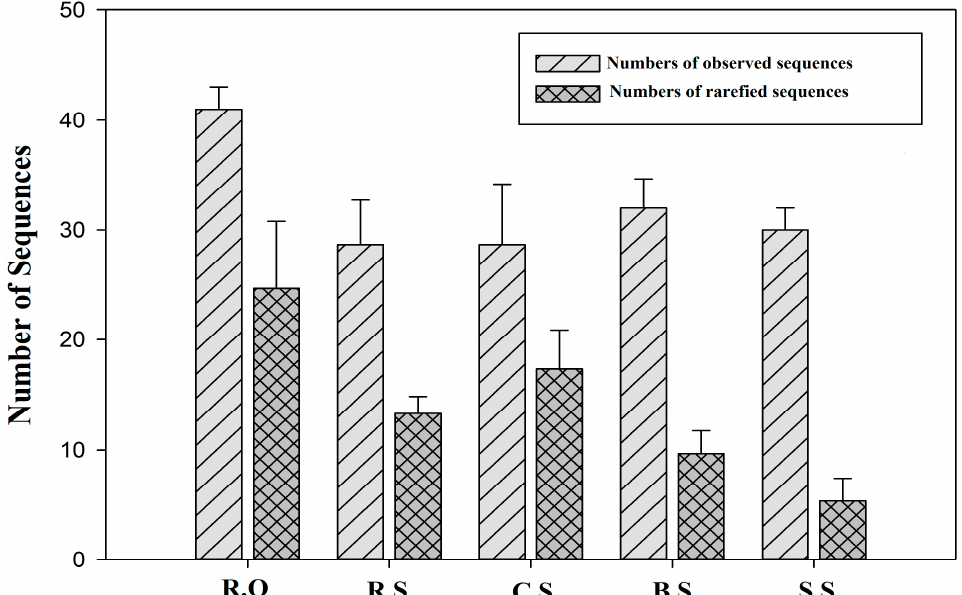
Figure 4. Number of observed and rarefied sequences (gene cassettes in each sample. R.O—agriculture effluent site, R.S—rice field site, C.S—citrus field site, B.S—banana site, S.S—sugarcane site. Each bar on the left indicates the average observed sequences, while the bars on the right indicate the rarefied sequences based on the clone libraries. Most rarefied sequences were higher for the R.O site, while the lowest numbers were found for the S.S site.